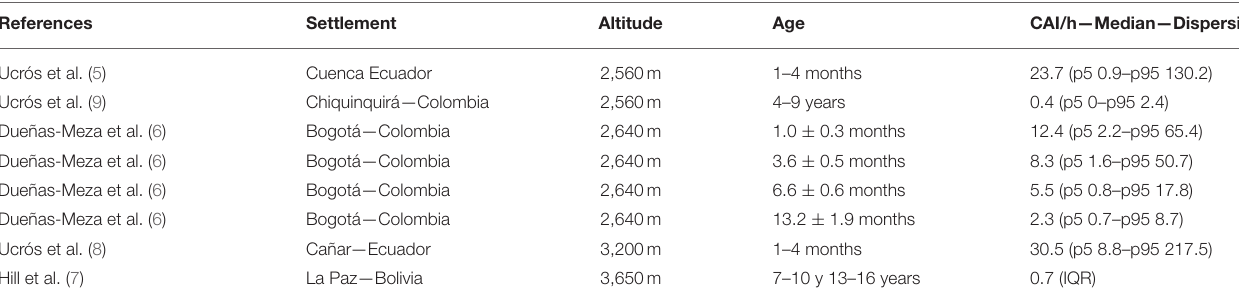
TABLE 2 | Central apnea index (CAI) according to altitude and